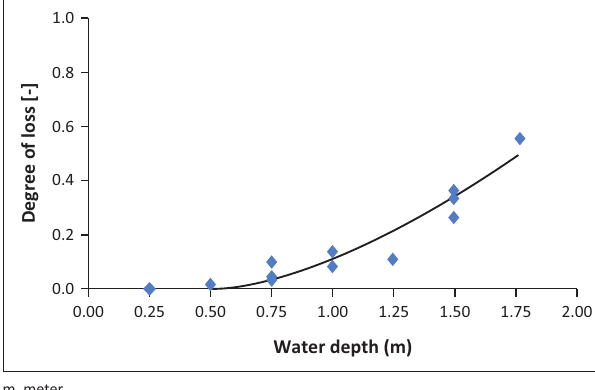
) and (b) the order-3 polynomial model (M 1